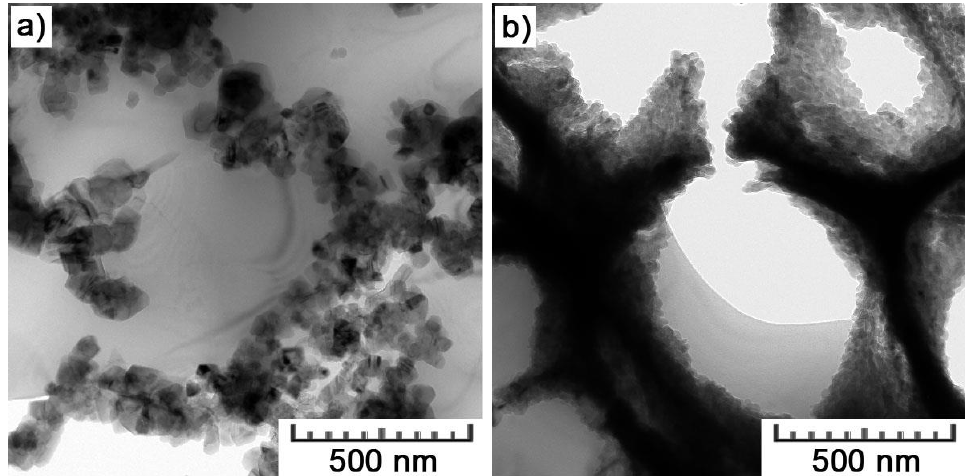
Figure 7. TEM bright field images obtained in the area of ( a ) a melt pool boundary and ( b ) a melt pool interior. pool